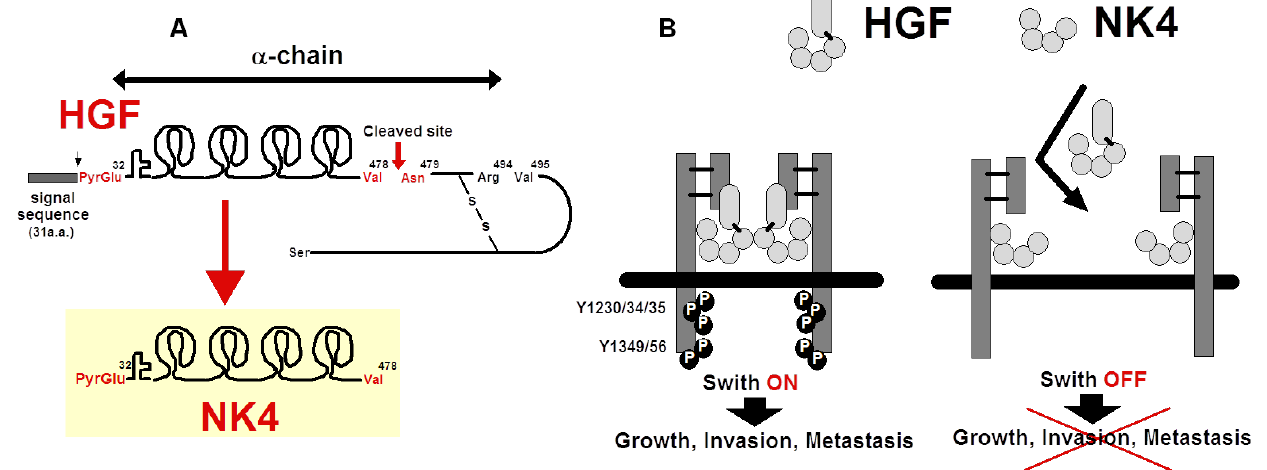
Figure 2. Preparation of NK4 as an HGF-antagonist. ( A ) Preparation and structure of NK4. NK4 is generated via a cleavage of HGF between 478th Val and 479th Asn [15]; ( B ) Inhibition of HGF-mediated MET tyrosine phosphorylation by NK4. NK4 alone binds to MET, but does not phosphorylate MET tyrosine kinases. Thus, the NK4–MET complex inhibits HGF–MET interaction via a masking of the HGF-binding motif in MET